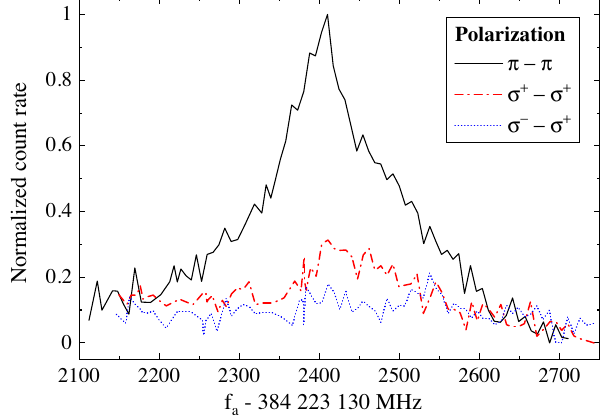
FIG. 3. Optical resonances of Li þ ions in the ESR recorded with different laser polarizations during the “ both lasers on ” phase (see text). The linear-linear case was recorded with both laser beams polarized in the horizontal (ring) plane. For circularly polarized light, the helicities of the UV (1st) and IR photons (2nd) are indicated. The x -axis represents the frequency of the IR light ( λ a ) produced by the diode laser that counterpropagates to the ion beam and drives the 2 3 S 1 ð F 2 ¼ 5 = 2 Þ → 2 3 P 2 ð F 3 ¼ 5 = 2 Þ tran- sition. The UV light ( λ p ) of the Ti-sapphire lasers second harmonic is copropagating and its frequency is fixed on the 2 3 S ð F ¼ 3 = 2 Þ → 2 3 P ð F ¼ 5 = 2 Þ resonance of the central 1 1 2 3 velocity group of the revolving